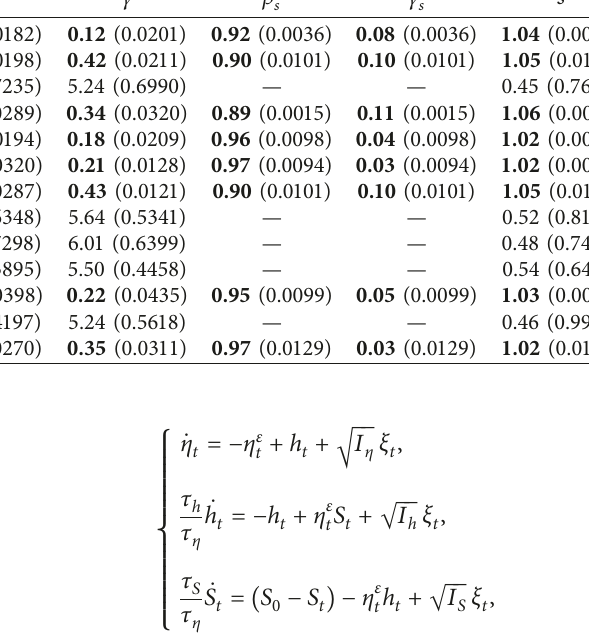
Table 1: Estimates of the values of the complexity spectrum indices for time series of microposts. Tweet Ids